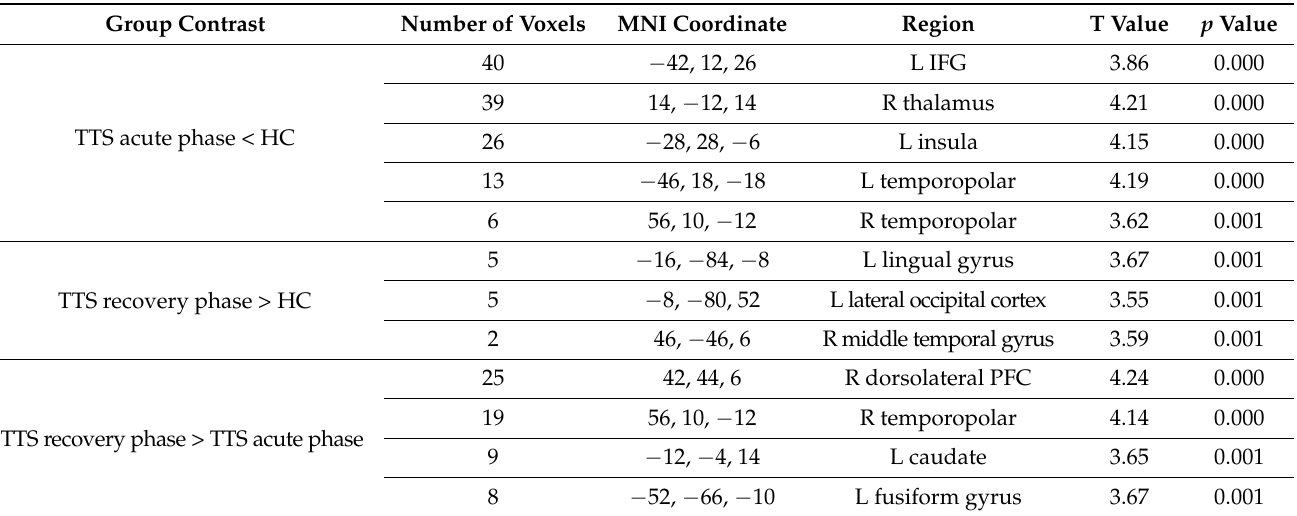
Table 2. Significant group differences between HC and TTS while viewing aversive versus positive pictures during emotional task-based fMRI paradigm.